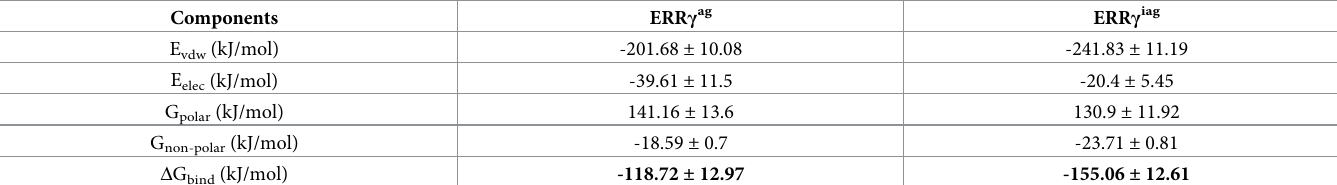
Table 1. Binding free energy calculations of ERR γ ag and ERR γ iag . Components